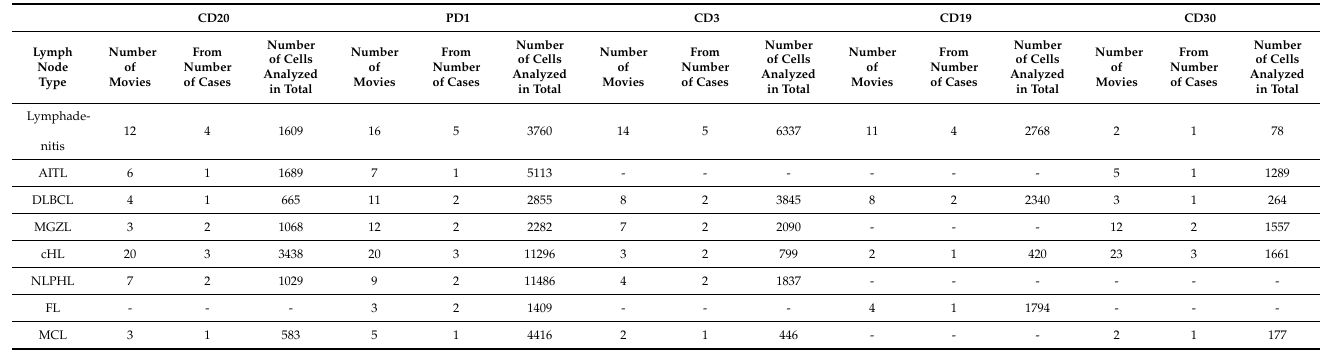
Table 1. Number of cells analyzed in the different